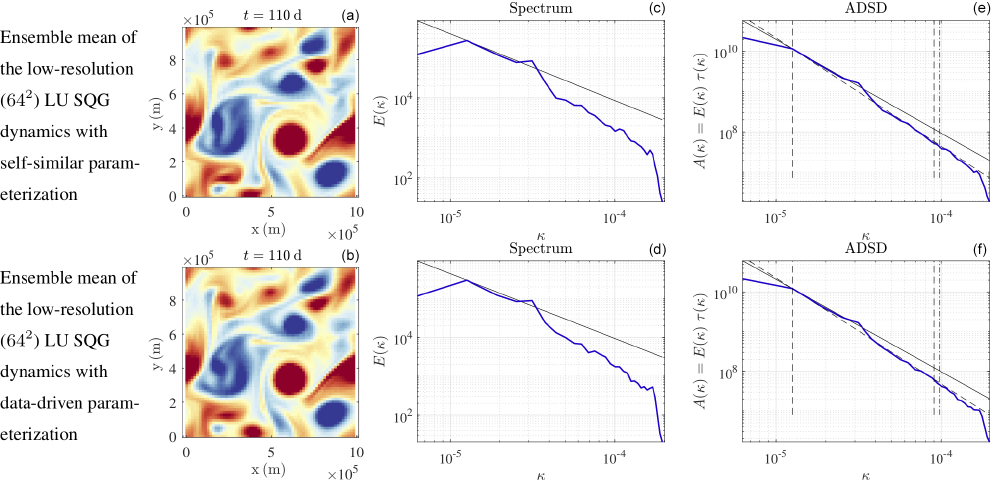
Figure 9. Buoyancy fields (ms − 2 ) (a, b) , kinetic energy spectra (m 2 s − 2 / (radm − 1 )) (c, d) , and ADSDs (m 2 s − 1 / (radm − 1 )) (e, f) of w , at t = 110d, for ensemble mean of the low-resolution (64 2 ) LU SQG dynamics (equivalent to SALT SQG) with self-similar parameteriza- tion (a, c, e) and with data-driven parameterization (b, d, f)